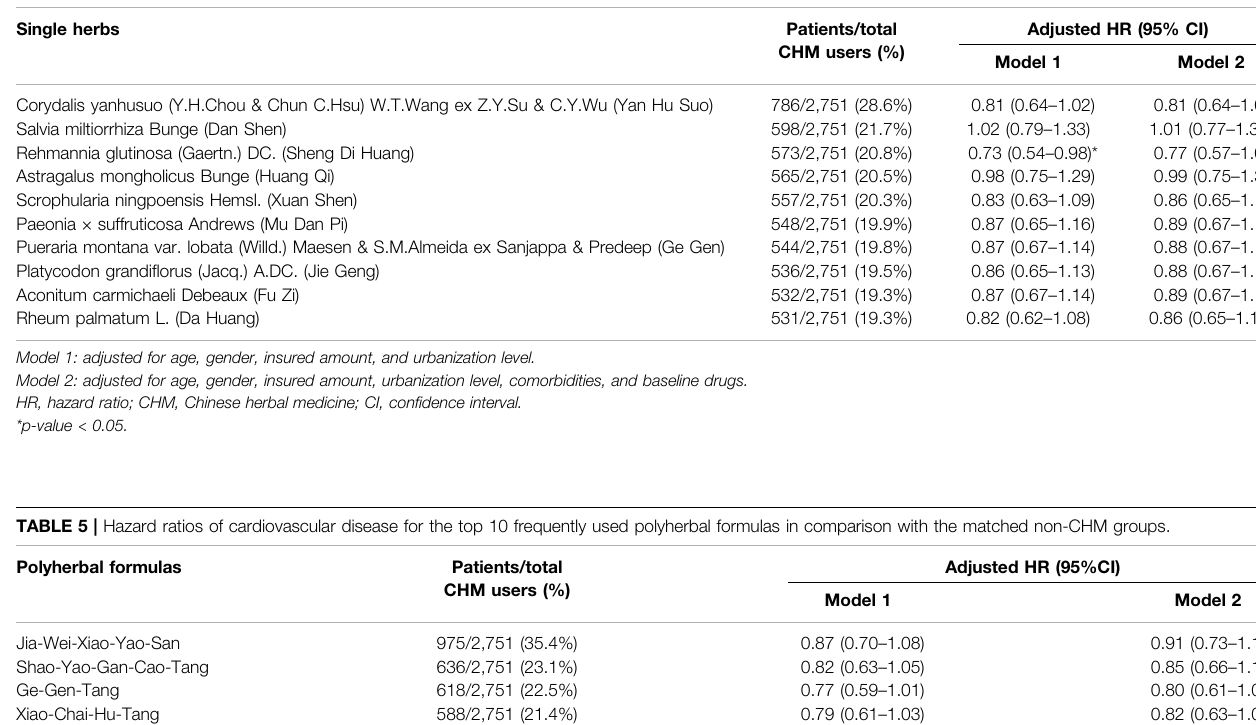
TABLE 4 | Hazard ratios of cardiovascular disease for the top 10 frequently used single herbs in comparison with the matched non-CHM groups. Single herbs